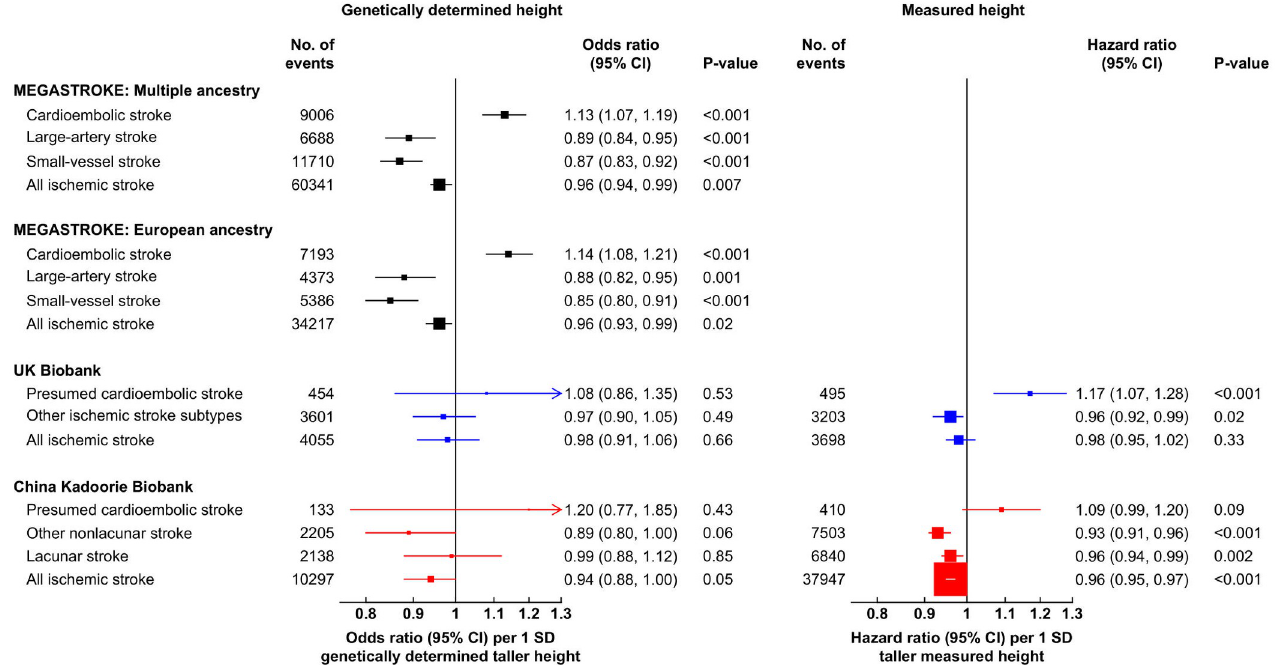
Fig 2. Associations of measured and genetically determined height with ischemic stroke and its subtypes in MEGASTROKE, UKB, and CKB. The numbers of events reported for MEGASTROKE were the maximum number of cases available in the genetic summary data. In MEGASTROKE and CKB, “All ischemic stroke” includes additional unsubtyped ischemic strokes. For UKB and CKB, respectively, the SDs of directly measured height were 6.8 cm versus 6.5 cm for men and 6.3 cm versus 6.0 cm for women. Genetic associations in UKB and CKB were adjusted for age, age 2 , sex, region (in CKB only), genomic principal components, and genotyping array type, and observational associations were stratified by age at risk (in 5-year groups), sex, and region (in CKB only) and adjusted for additional potential confounders (S6 Methods). CI, confidence interval; CKB, China Kadoorie Biobank; SD, standard deviation; UKB, UK